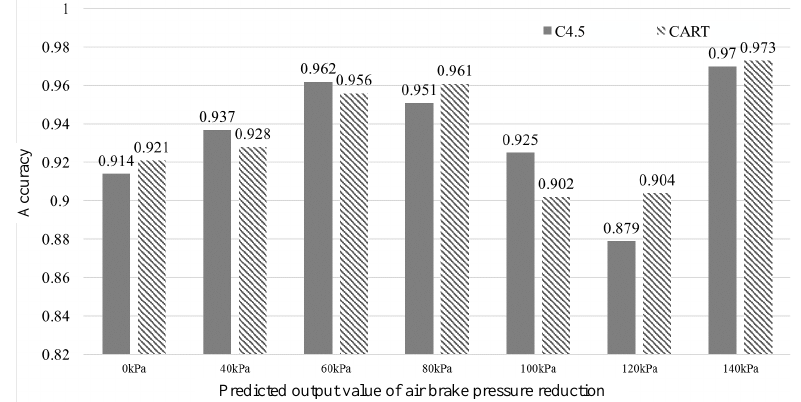
Figure 6. Prediction precision of C4.5 and CART algorithms.